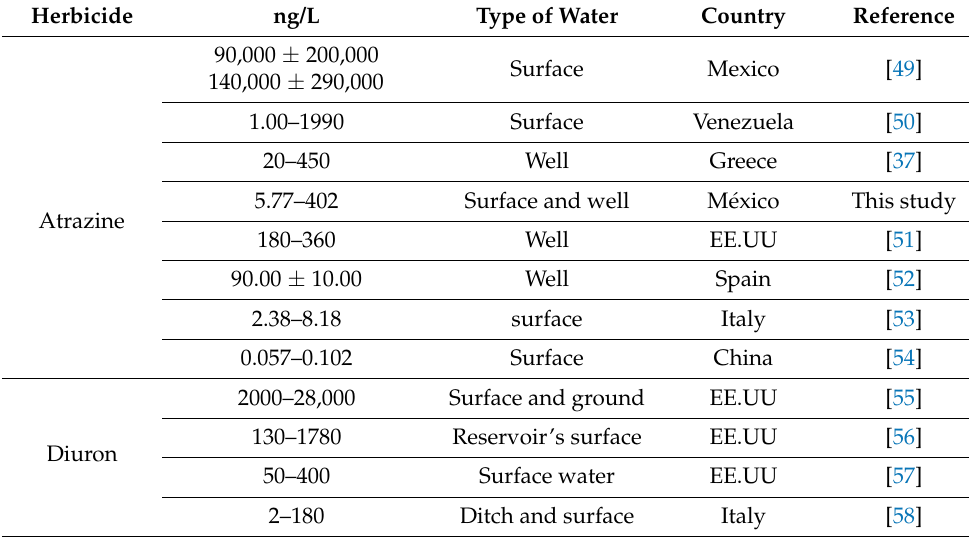
Table 1. Concentrations of herbicides in surface and well